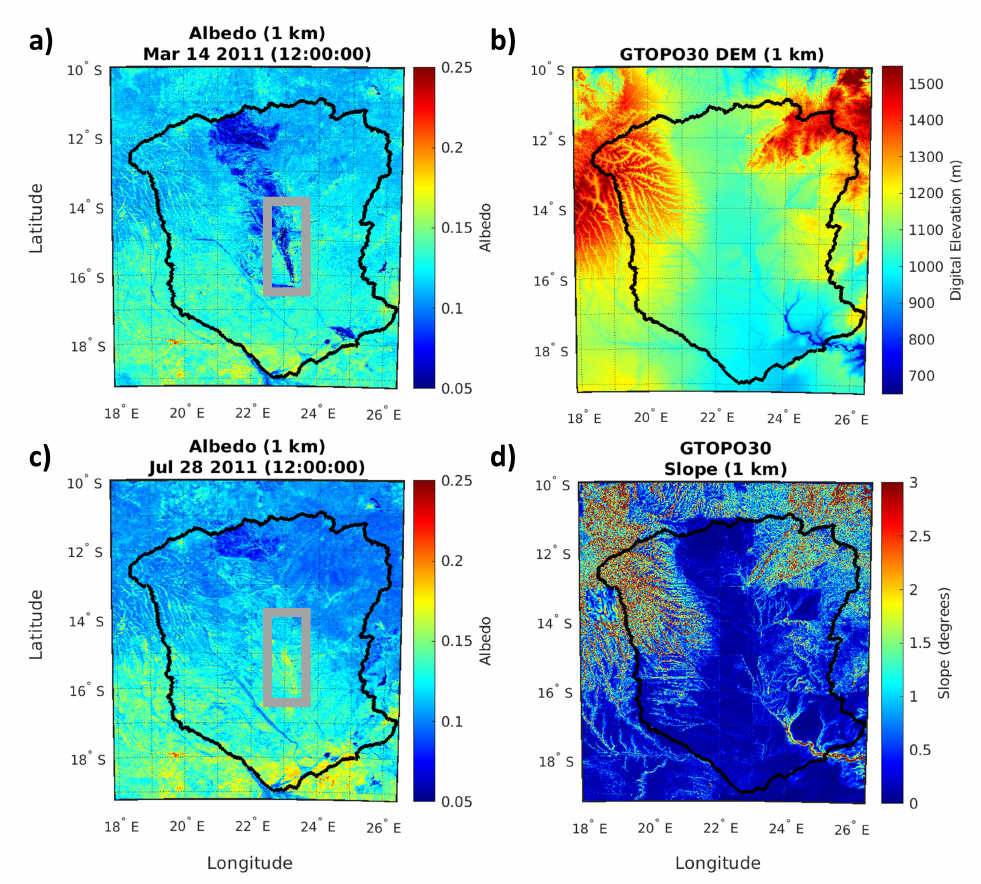
Figure 15. Shortwave broadband albedo at noon local time for 2011 ( a ) after the peak of the rainy season and ( c ) during the dry season compared with the corresponding ( b ) elevations and ( d ) terrain slope analysis. The gray box outlines an area with higher than expected albedo values during the dry